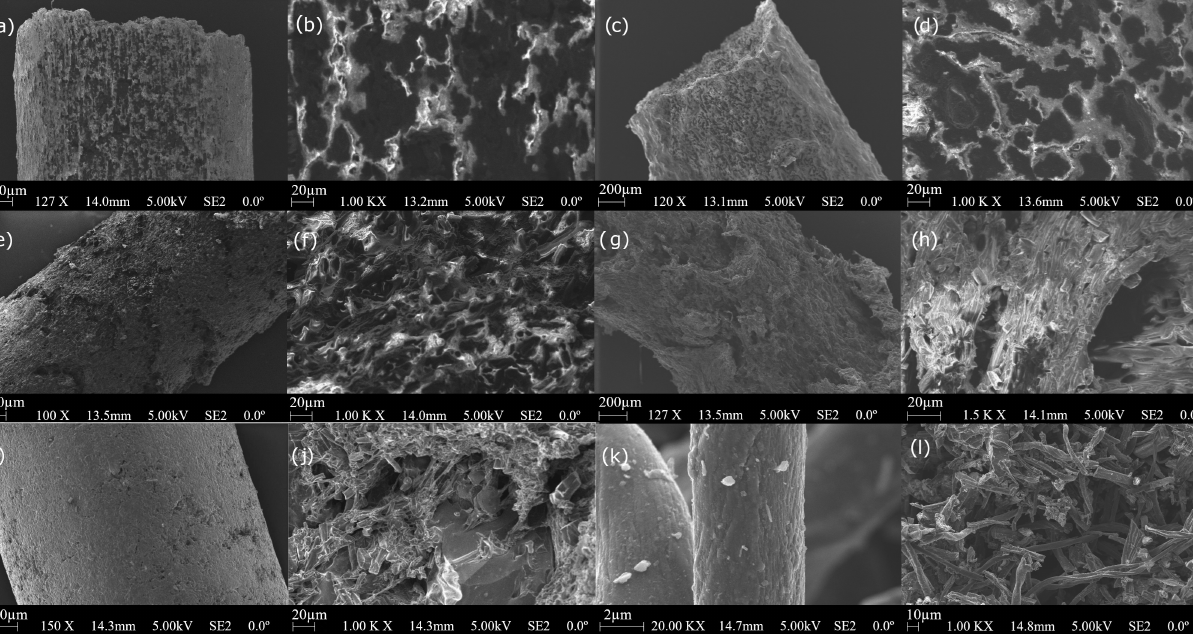
Figure 1. Scanning electron microscope images of ( a , b ) PMMA-biochar, ( c , d ) PLA-biochar, ( e , f ) ABS-biochar, ( g , h ) EVA- biochar ( i , j ), TPU-biochar (BC 60%) composites, and ( k , l ) biochar-derived from recycled cotton